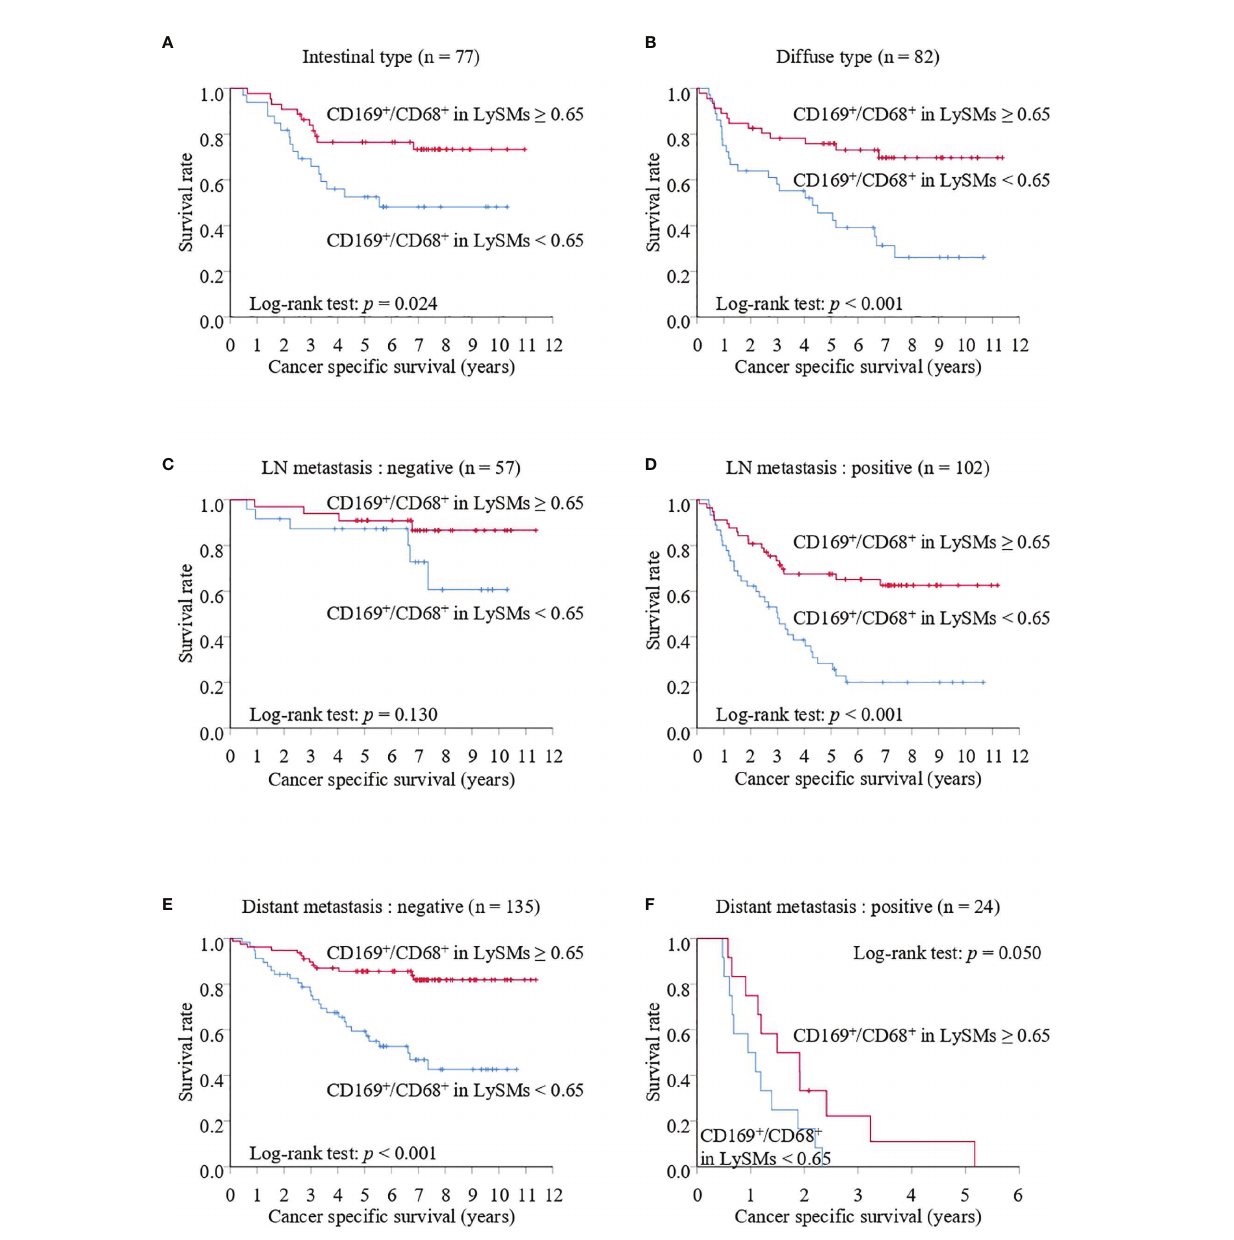
FIGURE 5 | Kaplan-Meier cancer-speci fi c survival (CSS) curves of CD169 + /CD68 + ratios in lymph node sinus macrophages (LySMs) of advanced gastric cancer patients with various tumor subtypes: intestinal type (A) or diffuse type (B) ; lymph node (LN) metastasis negative (C) and positive (D) ; distant metastasis negative (E) and positive (F)